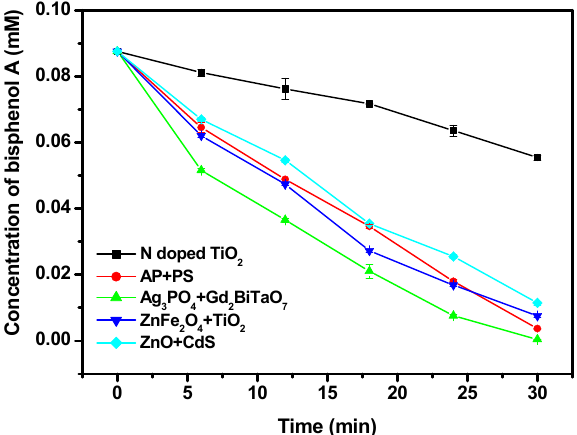
Figure 15. Concentration variation curves of bisphenol A during photocatalytic degradation of bisphenol A with Ag 3 PO 4 /Gd 2 BiTaO 7 heterojunction photocatalyst as photocatalyst, with N-doped TiO 2 as photocatalyst, with Ag 3 PO 4 and potassium persulfate as catalysts, with ZnFe 2 O 4 -TiO 2 nanocomposite as photocatalyst or with ZnO/CdS hierarchical heterojunction as photocatalyst under visible light irradiation.